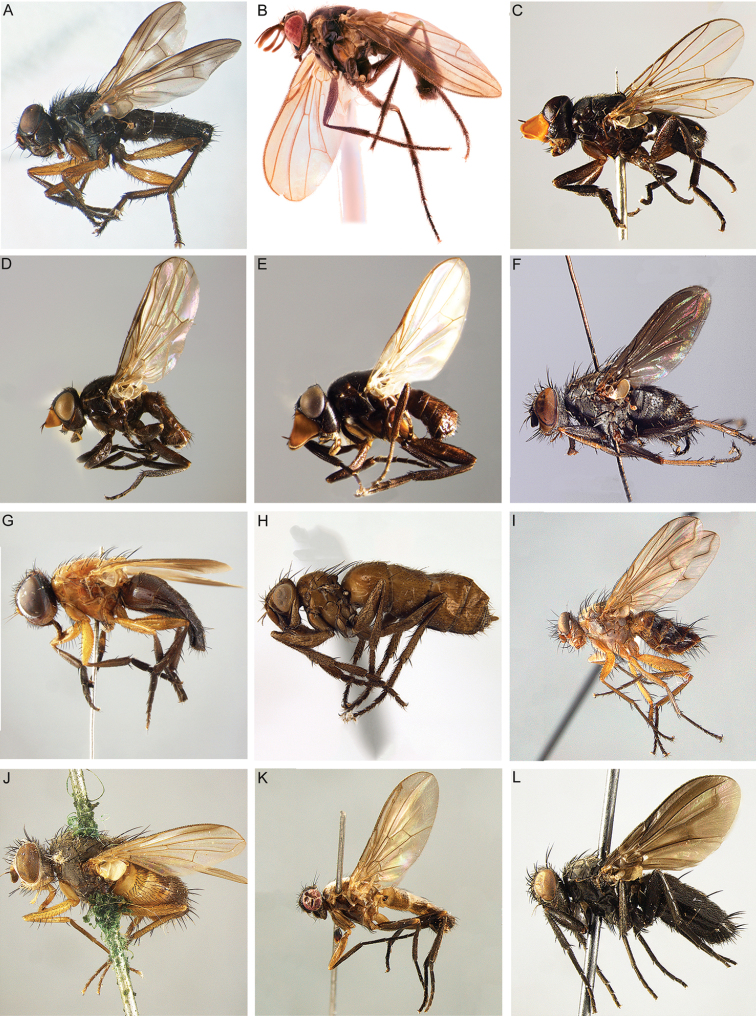
Rhinophoridae, habitus in lateral view. AApomorphyto
inbio ♂ (Costa Rica) [holotype] BAporeomyia sp. ♂ (Malaysia, Sabah) CAxinia
zantae ♂ (Australia) DAxinia
arenaria ♂ (Australia) EAxinia
brevispica ♂ (Australia) FAzaisia sp. ♂ (Portugal, Azores) GBaniassa
fascipennis ♀ (Israel) [paratype] HBezzimyia
hansoni ♀ (Costa Rica) IComoromyia sp. ♀ (Madagascar) JMacrotarsina
longimana ♂ (Italy) KMelanophora
basilewskyi ♂ (Kenya) LMelanophora
roralis ♂ (Italy).